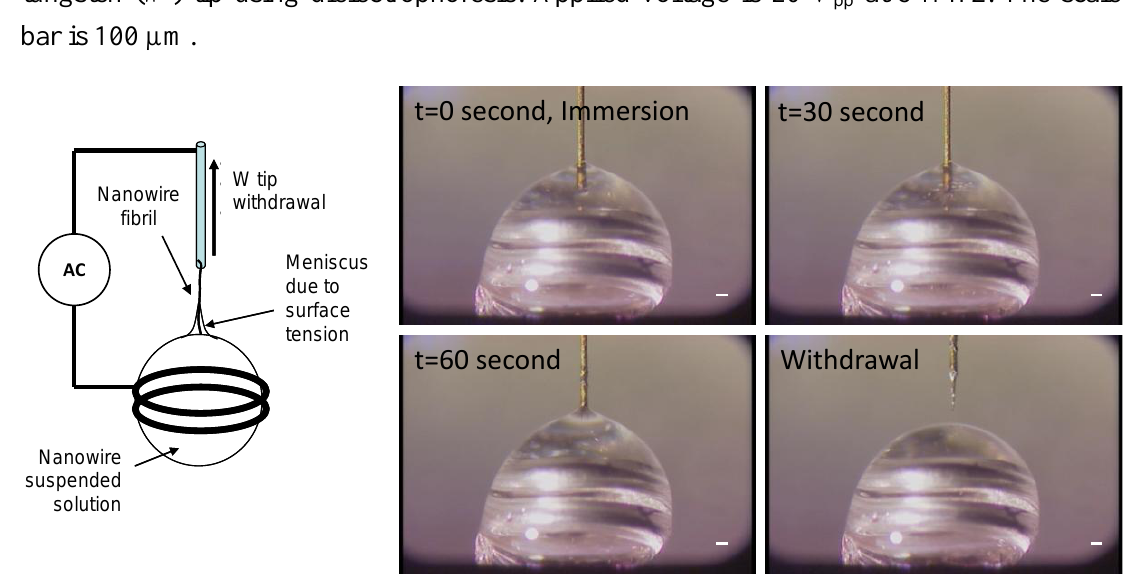
at 5 MHz. The scale pp